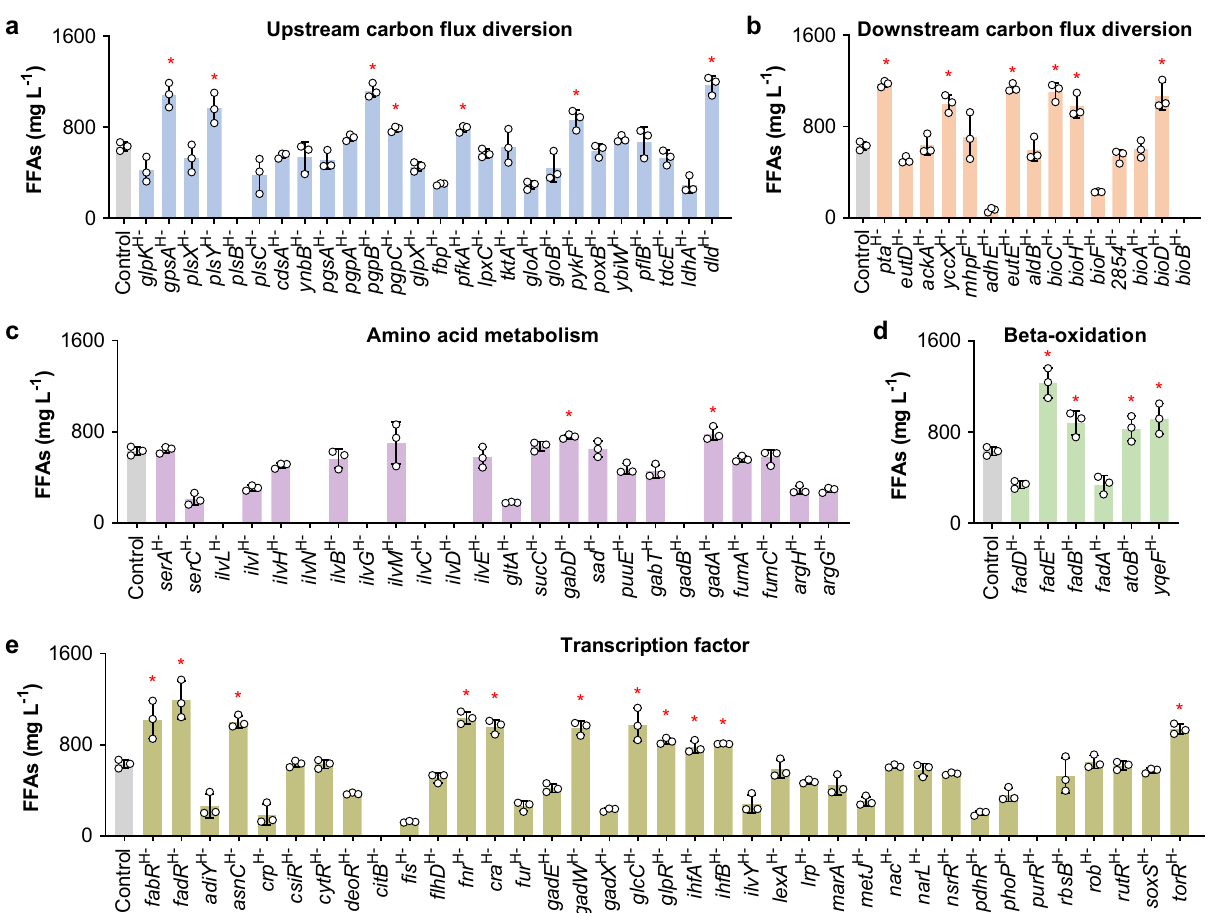
Fig. 2 CRISPRi-based identi fi cation of bene fi cial genes for FFAs production. All 108 genes in the upstream carbon fl ux diversion module ( a ), downstream carbon fl ux diversion module ( b ), amino acid metabolism module ( c ), beta-oxidation module ( d ), and transcription factor module ( e ) were repressed with high ef fi ciency. Asterisk represents the strain in which the FFAs titer increased by over 20% compared with that in the Control strain (631 mg L − 1 ), and the targeted genes are referred to as bene fi cial genes. The titers were obtained in batch cultivation of 30 g L − 1 glycerol. Data are presented as mean ± SD ( n = 3 biological replicates). Source data are provided as a Source Data fi